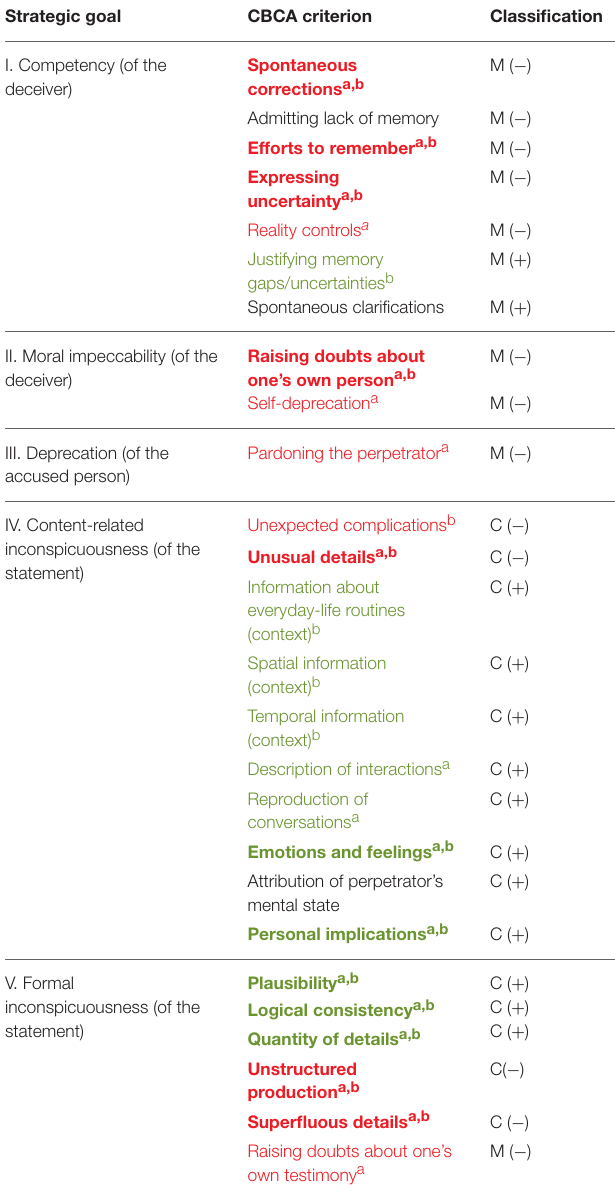
TABLE 2 | Strategic value ratings for CBCA criteria c (Niehaus et al., 2005; Niehaus, 2008). Strategic